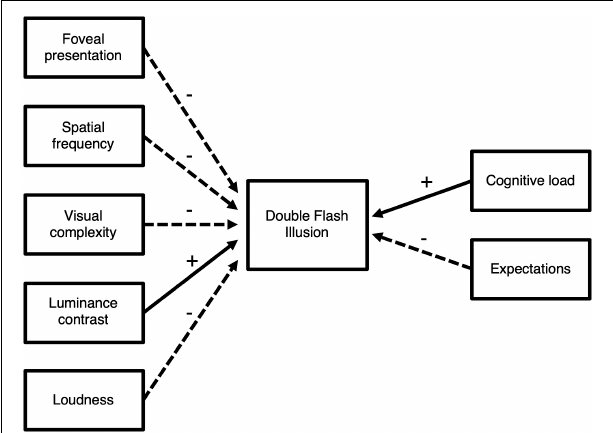
FIGURE 2 | Overview of the influence of stimulus and task characteristics on the illusion rate. Experimental evidence indicates that various manipulations of the constituting stimuli and the task increase (+, solid arrows) or decrease (–, dashed arrows) the likelihood of an